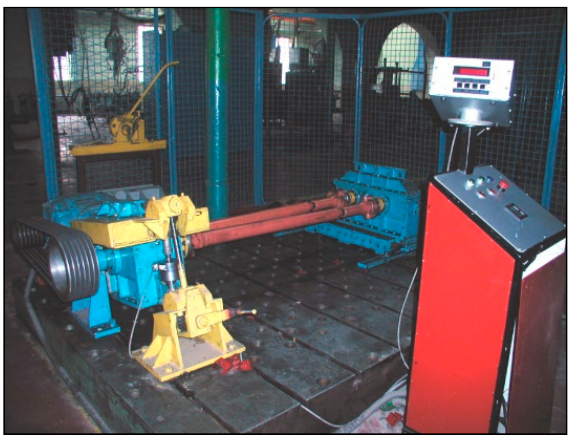
Figure 11. Gears’ testing device with closed circuit and reactive loader.